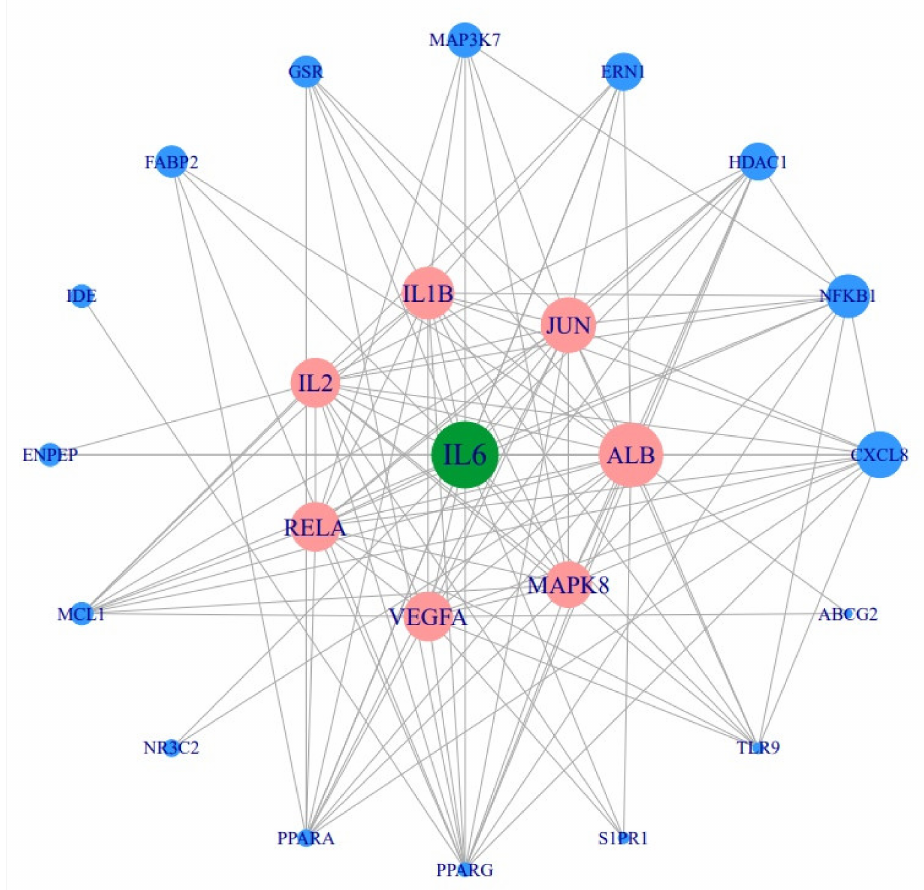
Figure 4. Gene–gene interaction with 27 nodes and 117 edges in PGCAM against COVID-19.